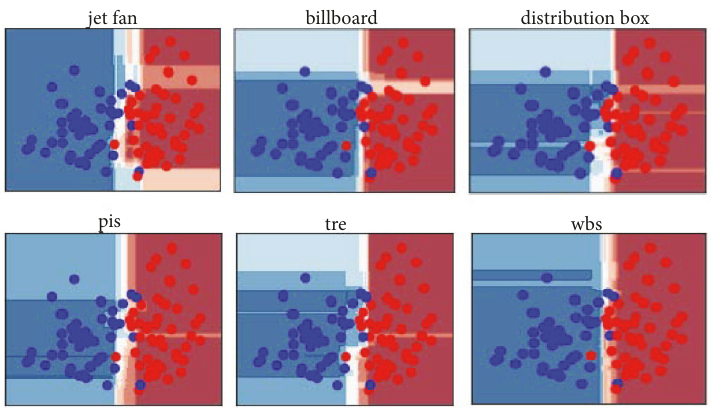
Figure 11: Results by random